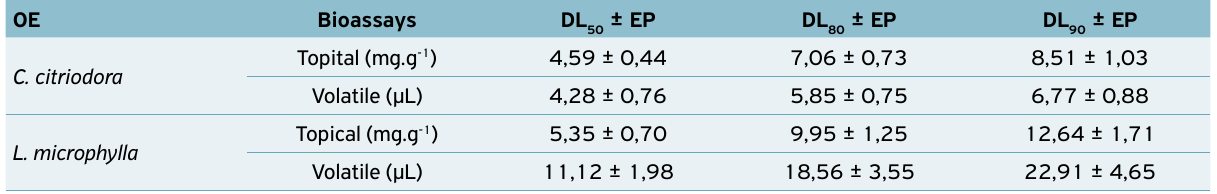
Table 1. Lethal doses of essential oil of Corymbia citriodora and Lippia microphylla for second-instar caterpillars Spodoptera frugiperda with topical and volatile application. OE